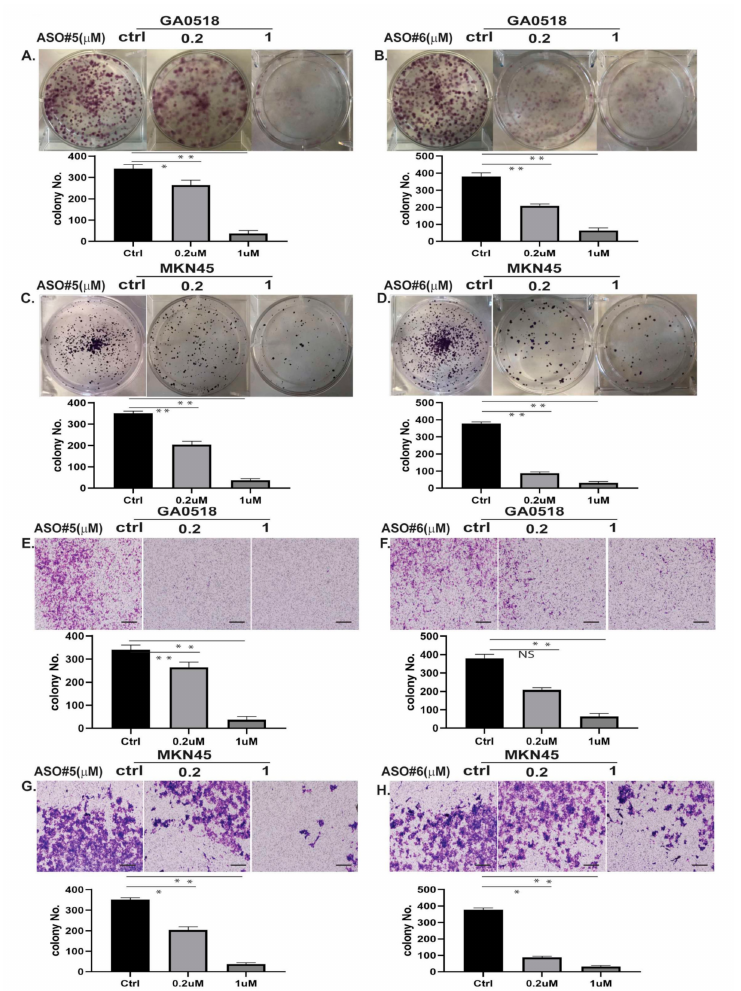
Figure 4. ASOs suppressed colony formation and cell invasion by inhibiting PVT1. ( A , B ) Colony formation of GA0518 cells was suppressed in a dose-dependent manner by ASO#5 ( A ) and ASO#6 ( B ). ( C , D ) Colony formation of MKN45 cells was suppressed in a dose-dependent manner by ASO#5 ( C ) and ASO#6 ( D ). ( E , F ) Cell invasion of GA0518 cells was suppressed in a dose-dependent manner by ASO#5 ( E ) and ASO#6 ( F ). ( G , H ). Cell invasion of MKN45 cells was suppressed in a dose-dependent manner by ASO#5 ( G ) and ASO#6 ( H ) scale bars = 40 µ m. * p < 0.5; ** p <